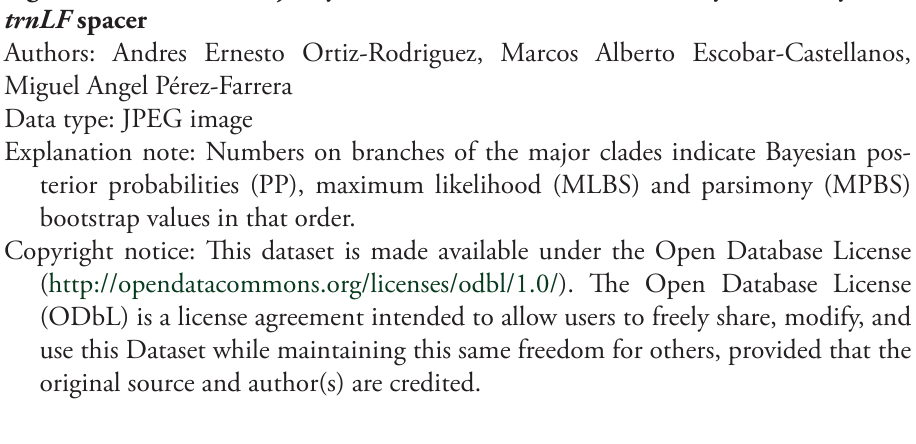
Figure S4. The 50% majority-rule consensus tree from the Bayesian analysis of trnLF